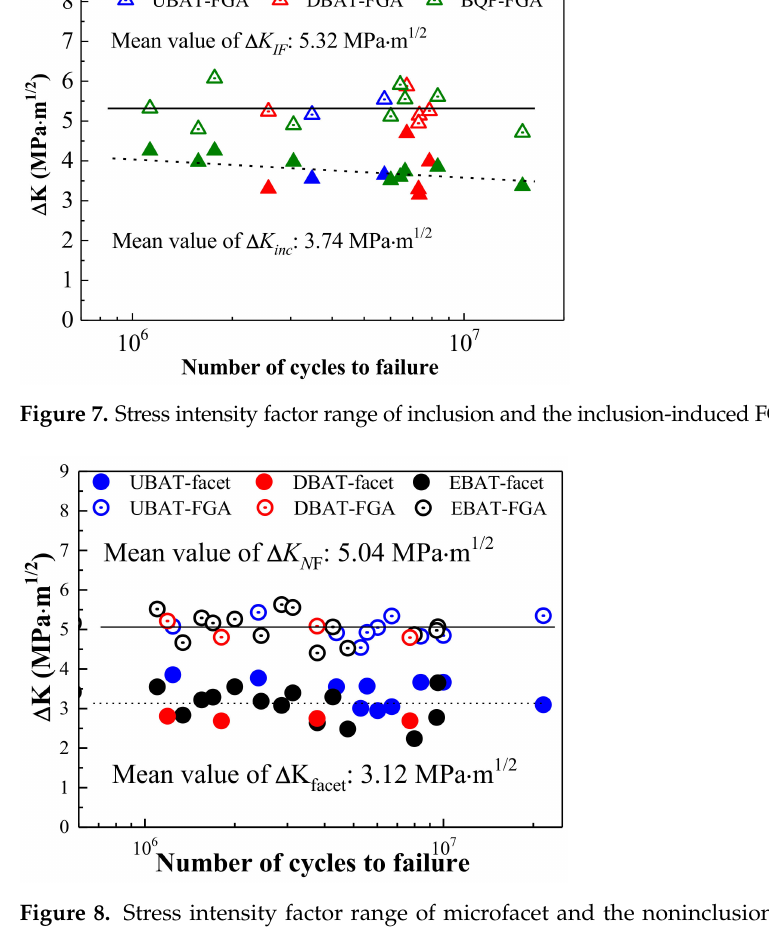
Figure 8. Stress intensity factor range of microfacet and the noninclusion-induced FGA (NF) of bainitic steels.